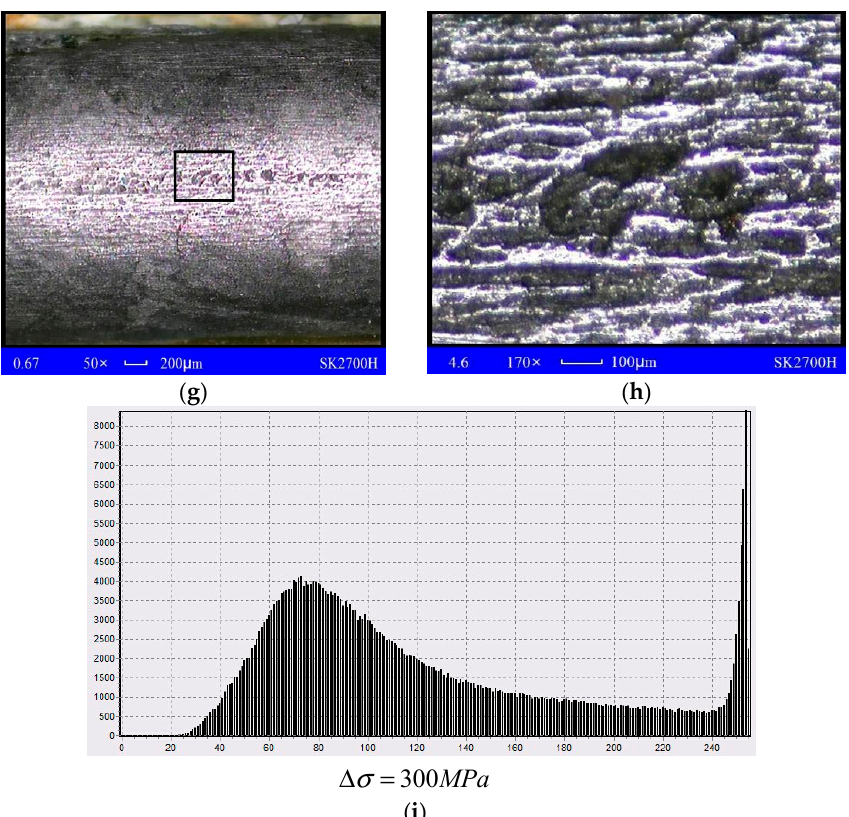
Figure 5. Test results ( a , b , d , e , g , h ); Local corrosion histogram of steel strand ( c , f , i ).